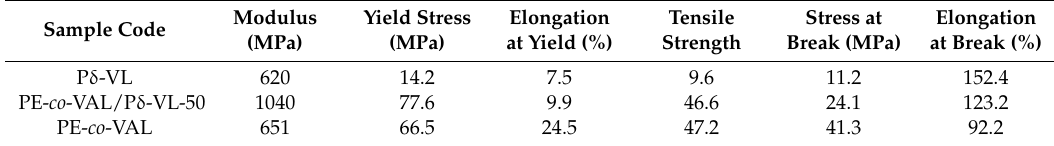
Figure 9. Strain-stress curves of PE- co -VAL/P δ -VL50 system and their components. Table 5. Mechanical properties of PE- co -VAL/P δ -VL50 blend and its pure